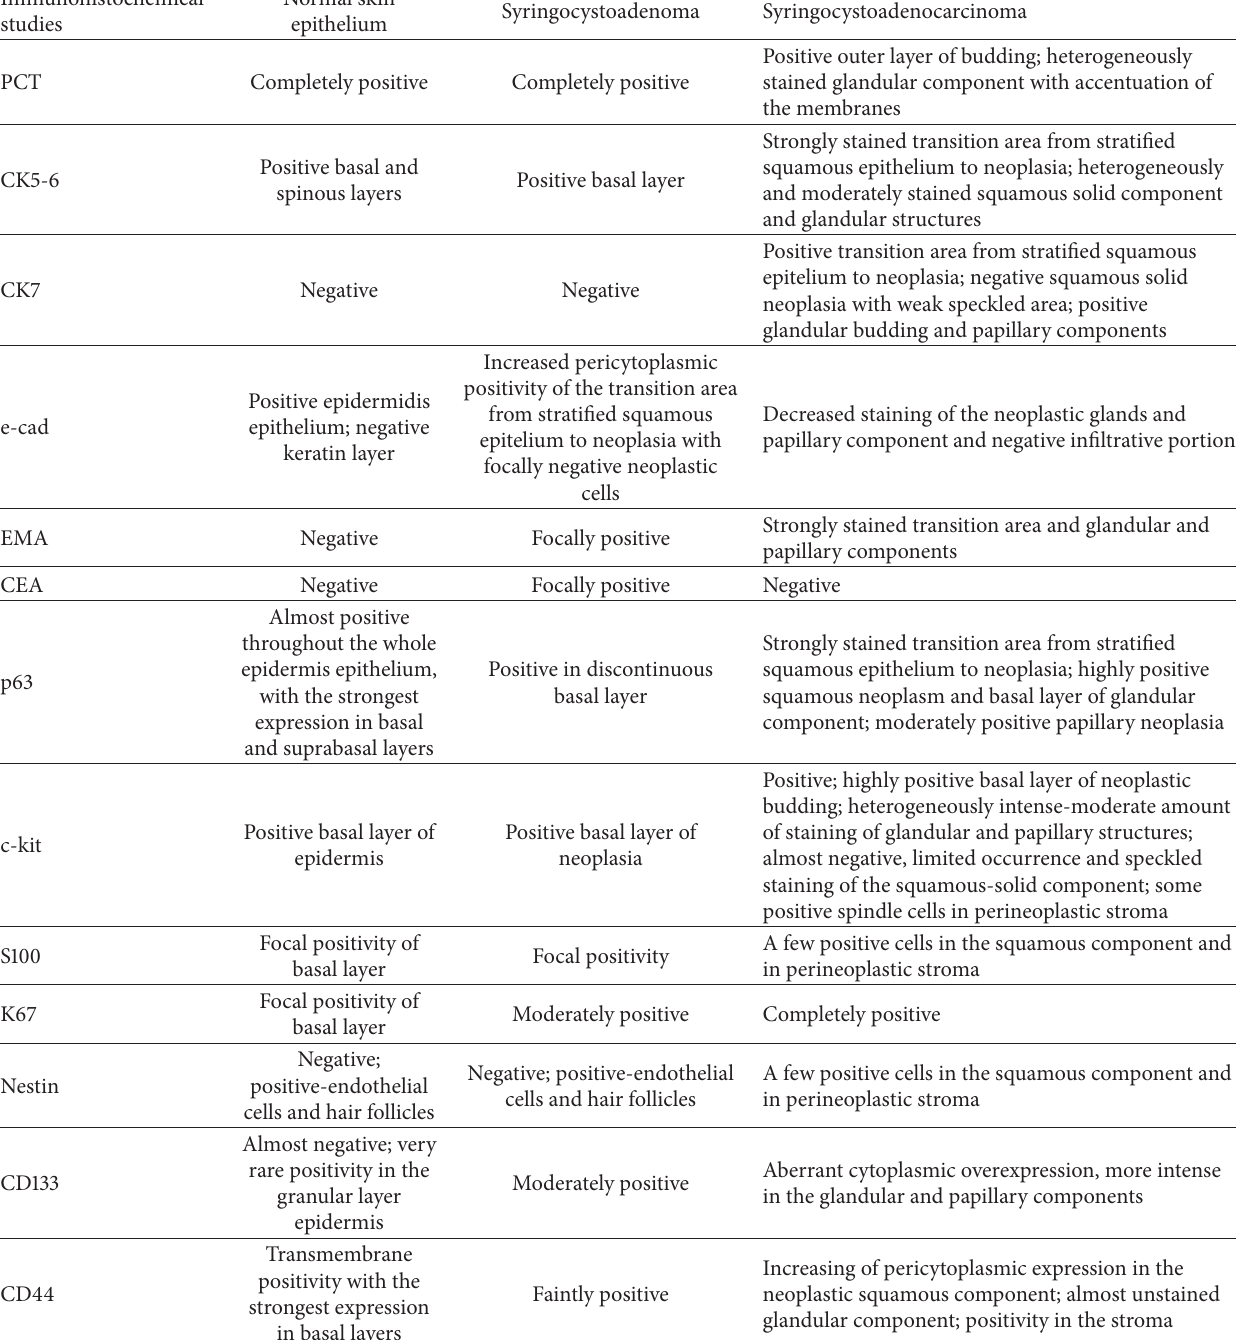
Table 2: Antigen expression of syringocystadenocarcinoma